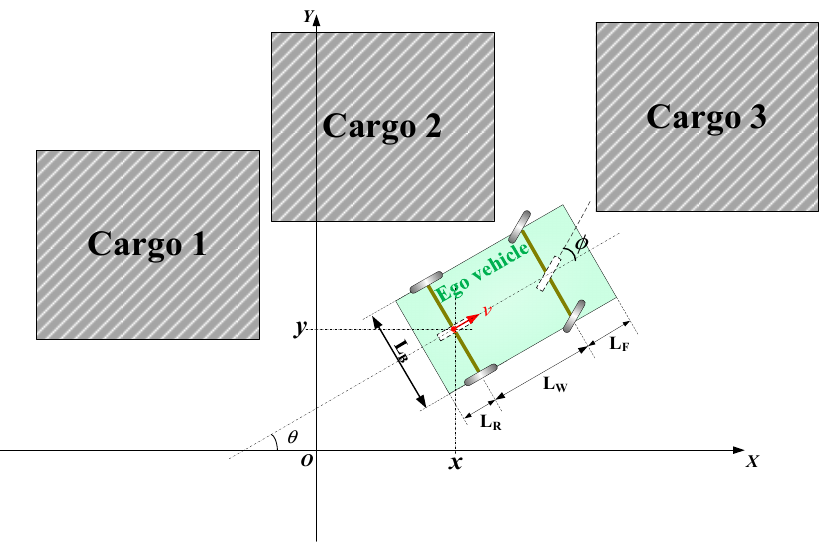
Figure 3. Schematics for vehicle kinematics and